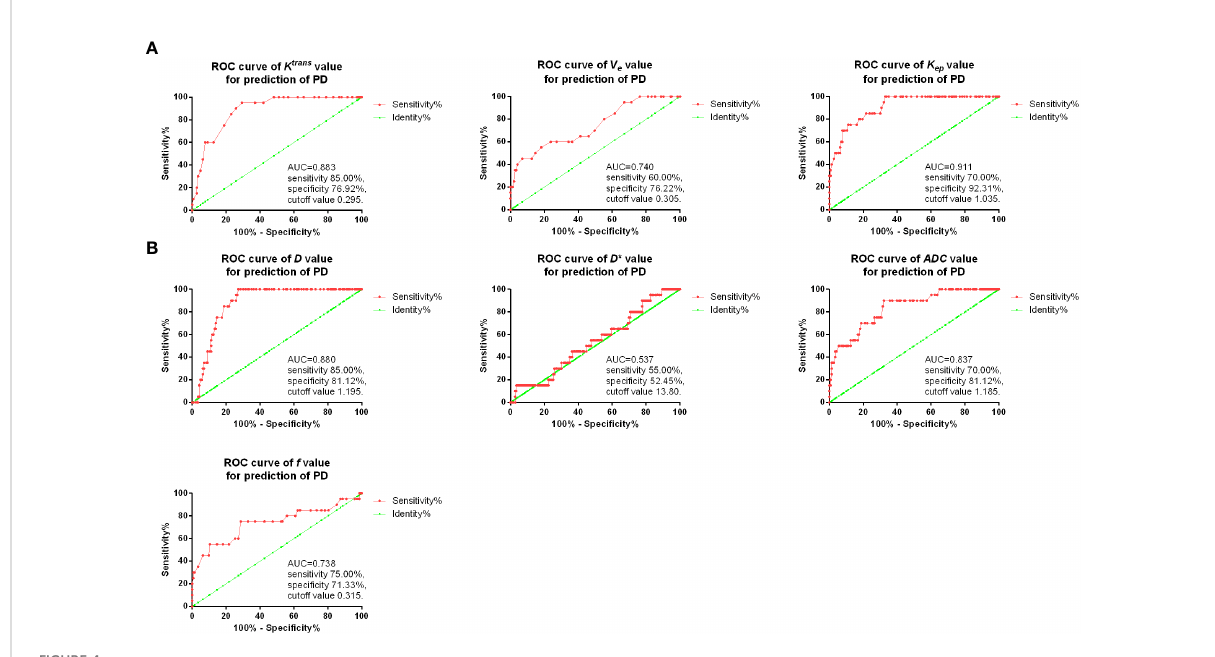
FIGURE 4 ROC curves of K trans , K ep , and V e (A) , as well as D , D* , ADC and f (B) in predicting PD.